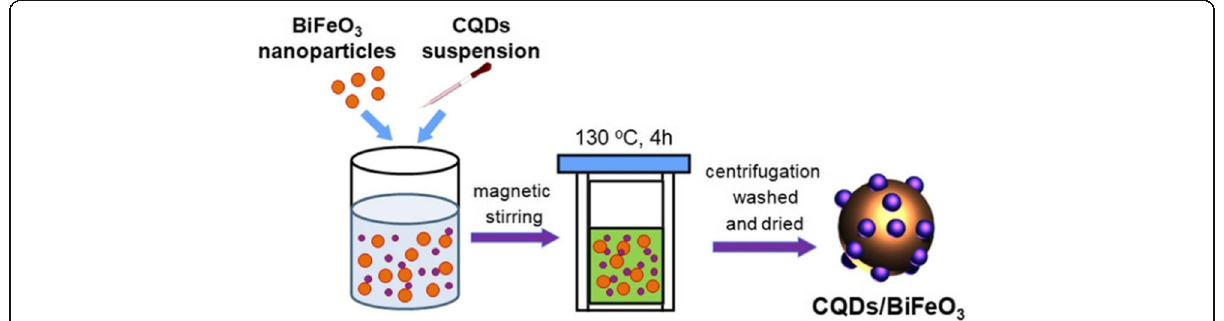
Fig. 1 The schematic illustration of preparation process for CQDs/BiFeO 3